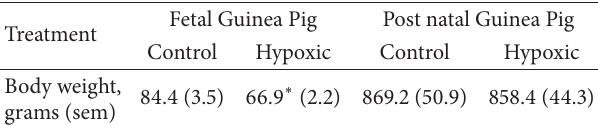
Table 1: Effects of MH on body weights of fetal guinea pigs at 62 d gestation and postnatal guinea pigs at day 120. Values are means ( ± SEM), 𝑛 = 5 . Fetal Guinea Pig Post natal Guinea Pig Treatment Control Hypoxic Control Hypoxic Body